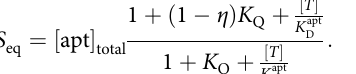
Target binding to the aptamer depletes the unfolded state, shifting the quenching reaction towards the unfolded state, generating more signal. Assuming a quenching ef fi ciency of η , this equilibrium shift generates a target concentration-dependent